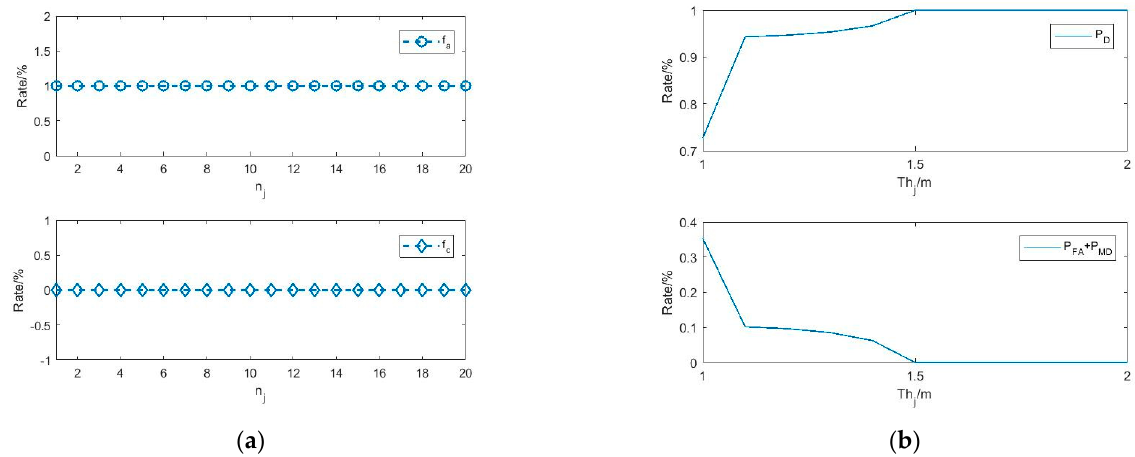
Figure 10. The impact of jump parameter settings: ( a ) the impact of jump verification window; ( b ) the impact of jump verification threshold ( n j =